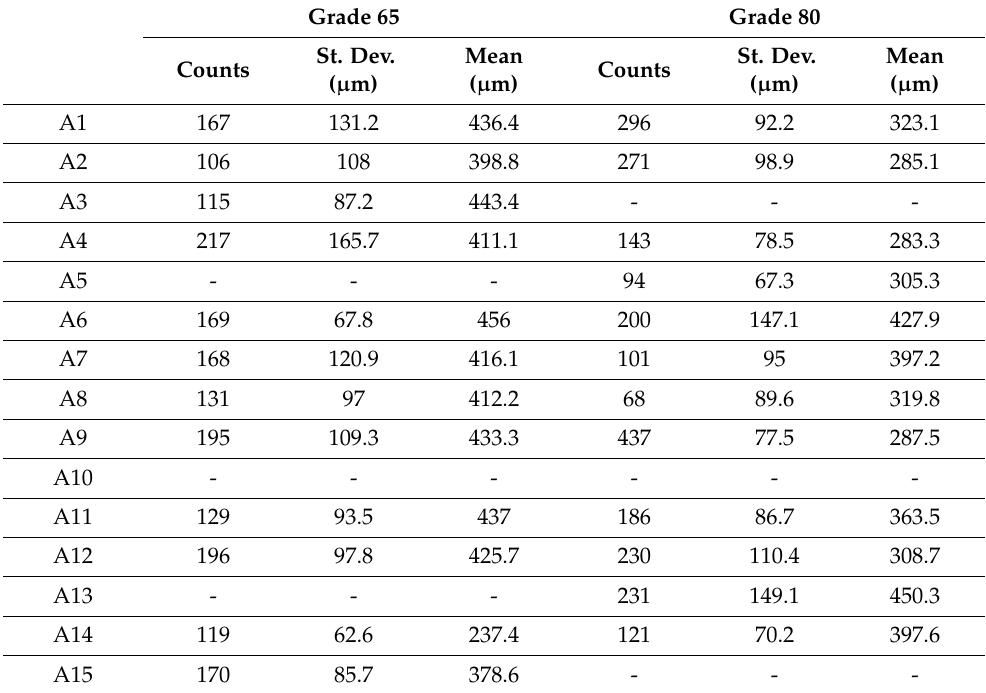
Table A6. Mean Window’s Feret diameter ( d w ) of CFF samples of Grade 65 and Grade 80 from supplier A.